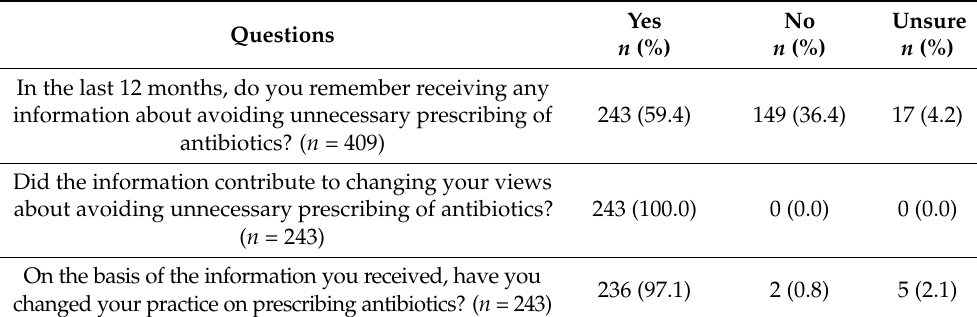
Table 3. Number of respondents (%) who received information on avoiding unnecessary prescribing of antibiotics and, of those, the number (%) reporting that the information contributed to changing their views or